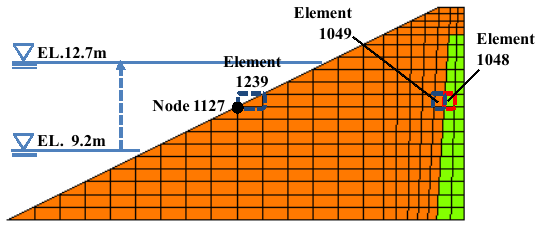
Fig. 15. Locations of node and elements to study behavior of reservoir side of levee due to water level raising